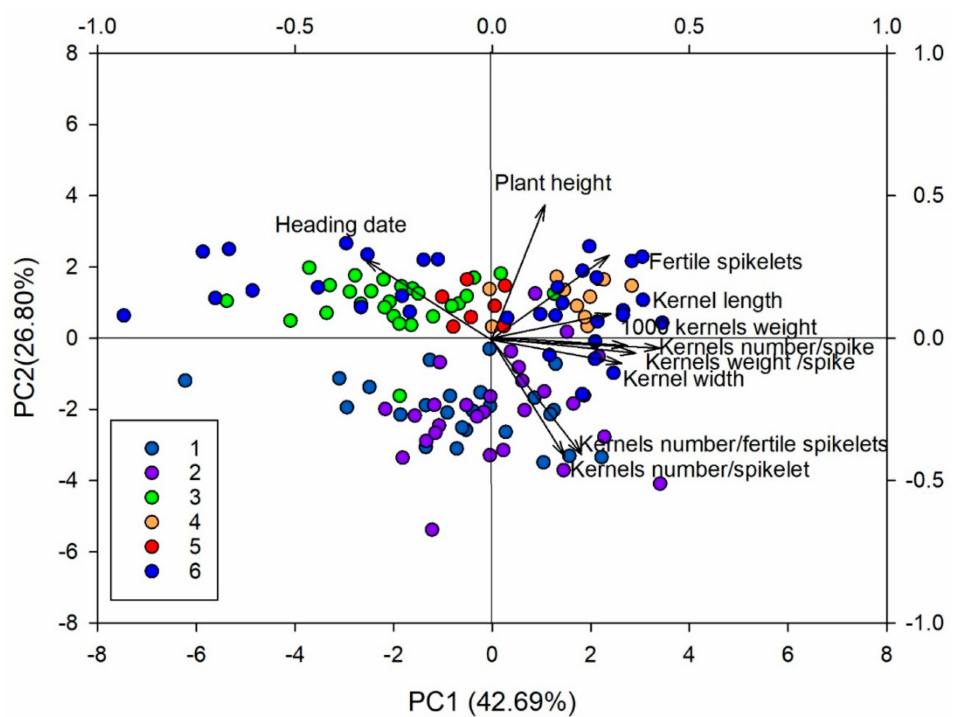
Figure 5. Principal component analysis (PCA) and cumulative proportion of total variance for the first and second PC for 136 accessions and 28 durum wheat varieties. Different colors are used for the six groups uncovered by the DAPC. Arrows indicate the loadings for each trait along the first two